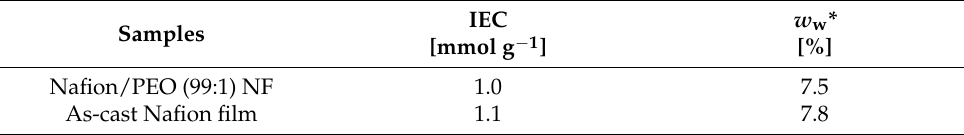
Table 1. Physicochemical properties of the prepared Nafion/PEO composite